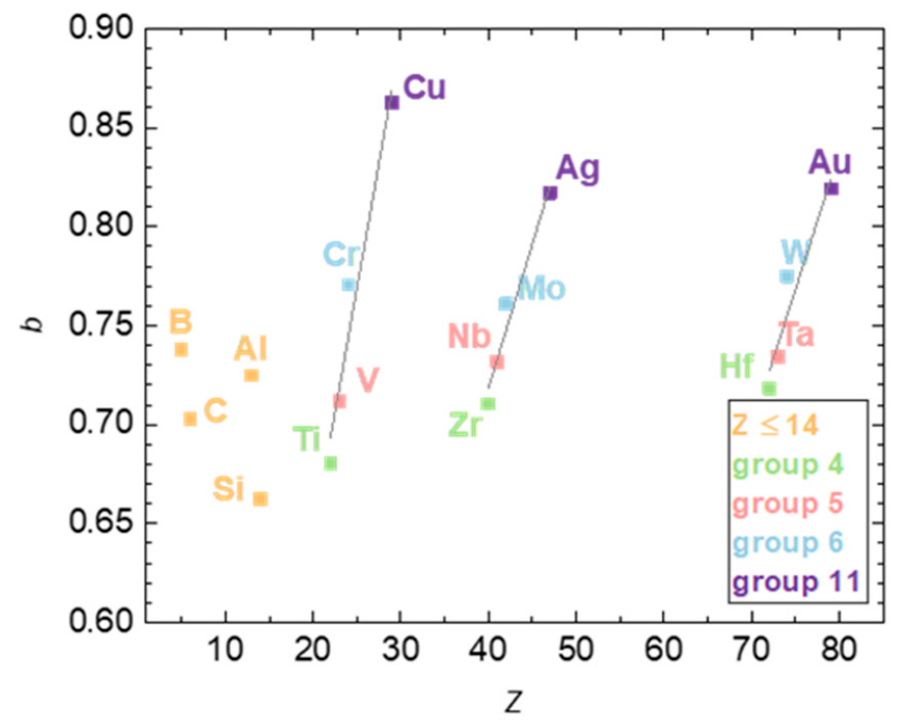
Figure 14. Fitting parameter b calculated from Equation (22) in dependence of atomic number.